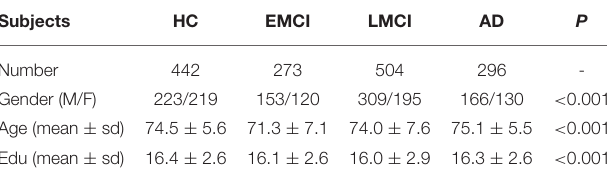
TABLE 1 | Participant